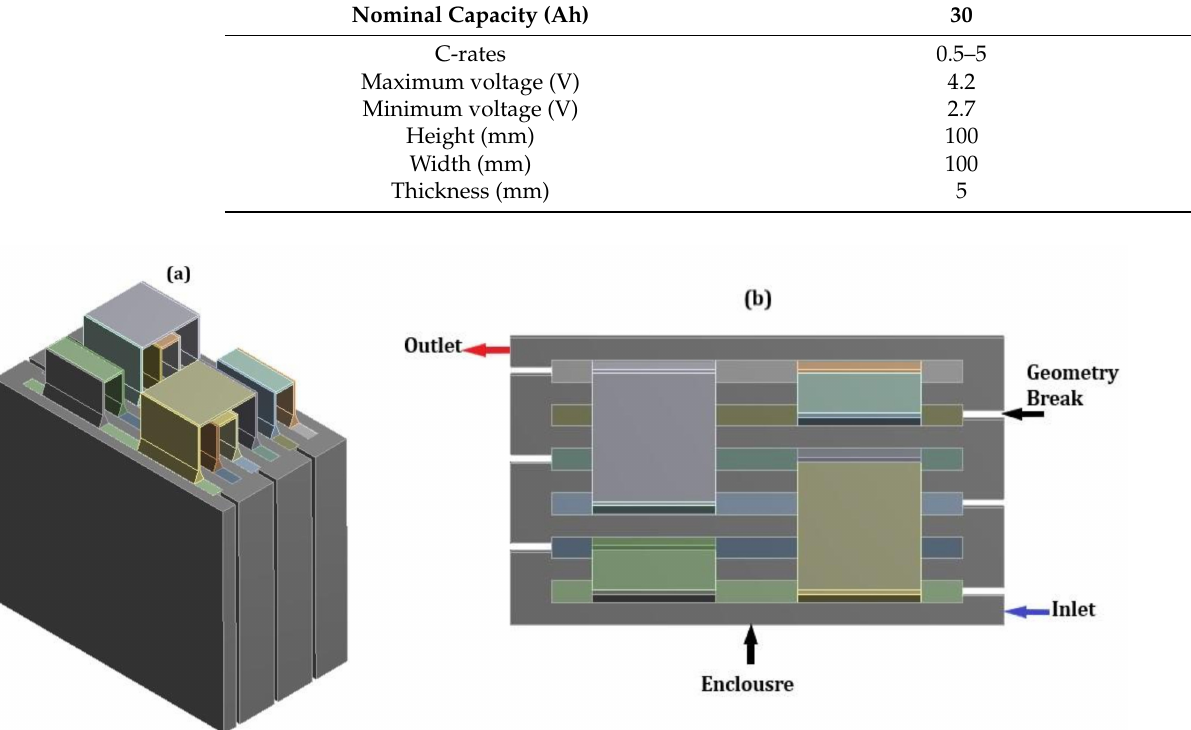
Figure 2. Schematic of the 3S2P LIB enclosure geometry, showing ( a ) isometric view and ( b ) top view of the